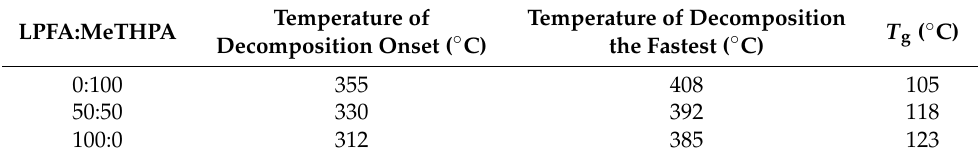
Table 2. Thermal properties of the cured epoxy resins by different anhydrides.